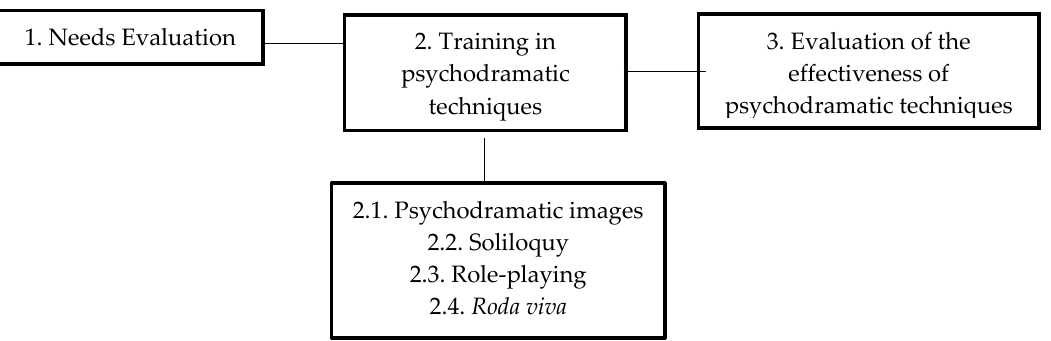
Figure 1. Structure of Training in Teaching Skills: Educational Psychodrama.